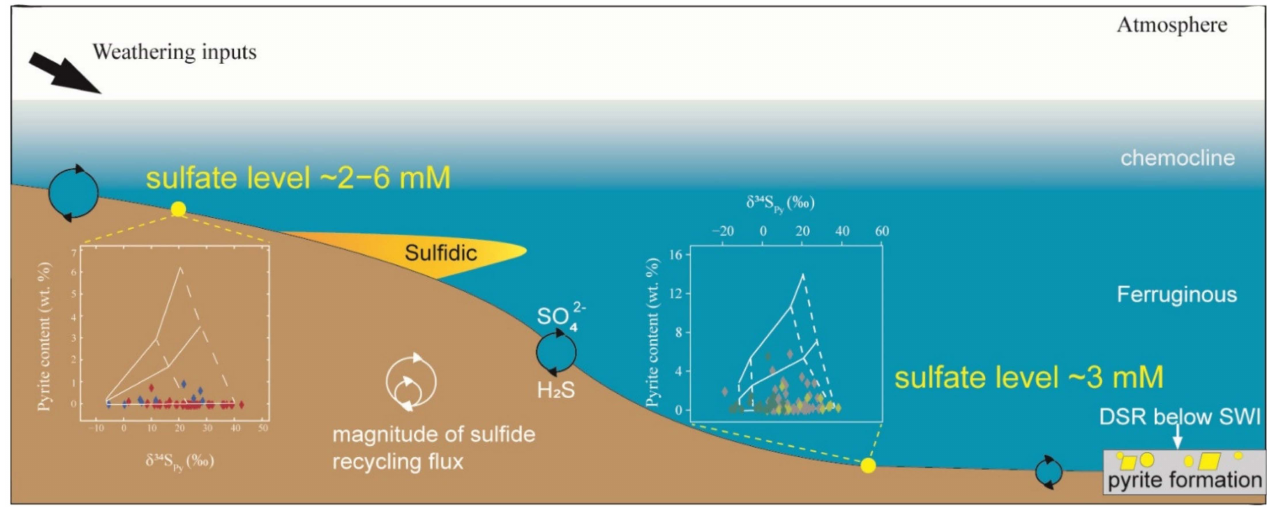
Figure 8. Conceptual model of the marine sulfur cycle and sulfate levels during the Ediacaran–Cambrian